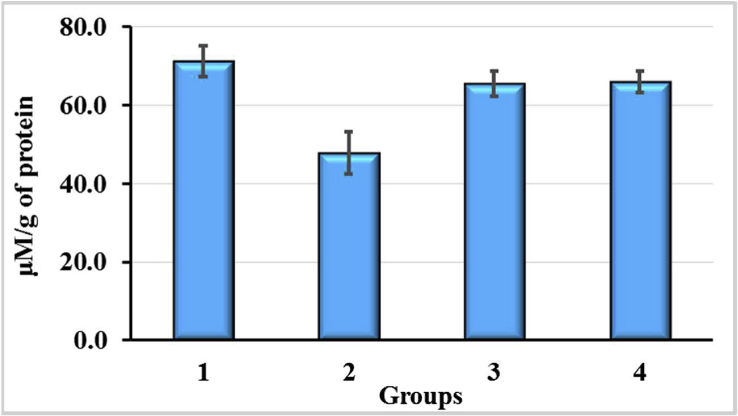
Malondialdehyde (MDA) levels in the blood plasma of rats exposured to CCl4 and enterosorbents, p < 0.05.